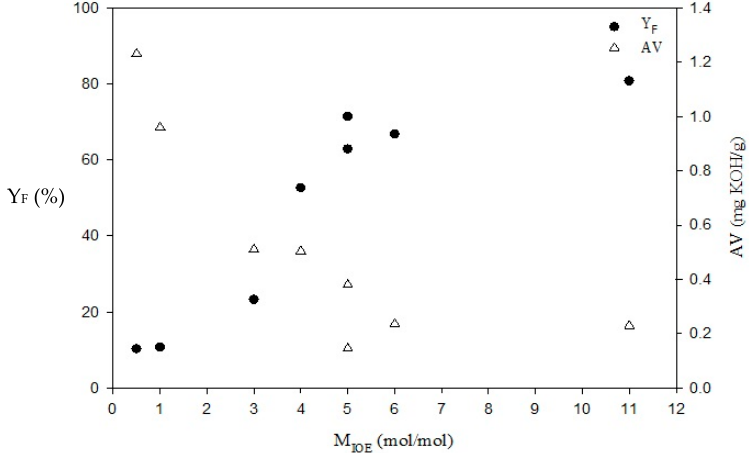
Figure 2. Effects of M IOE on Y F and AV for esterification of JO. m O = 200 g, T E = 394.2 K, M H/HO = 0.94 wt.%, Q IPA/H = 1.5 mL/min. P UI = 420 W.